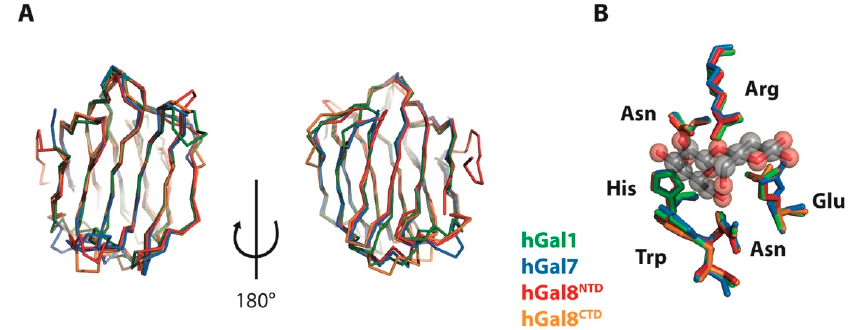
Figure 1. Superimposition of X-ray crystal structures of hGal1, hGal7, hGal8 NTD , and hGal8 CTD . ( A ) Ribbon representation of the crystal structures of hGal1 (protein database entry (PDB ID): 1W6N; green), hGal7 (PDB ID: 1BKZ; blue), hGal8 NTD (PDB ID: 3VKN; red), and hGal8 CTD (PDB ID: 3OJB; orange) are shown here on two sides; ( B ) Detailed views of structural alignment of lactose binding residues. The side-chains of individual residues are coloured in the same way.